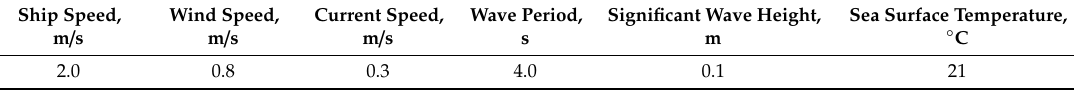
Table 2. Experimental environment and